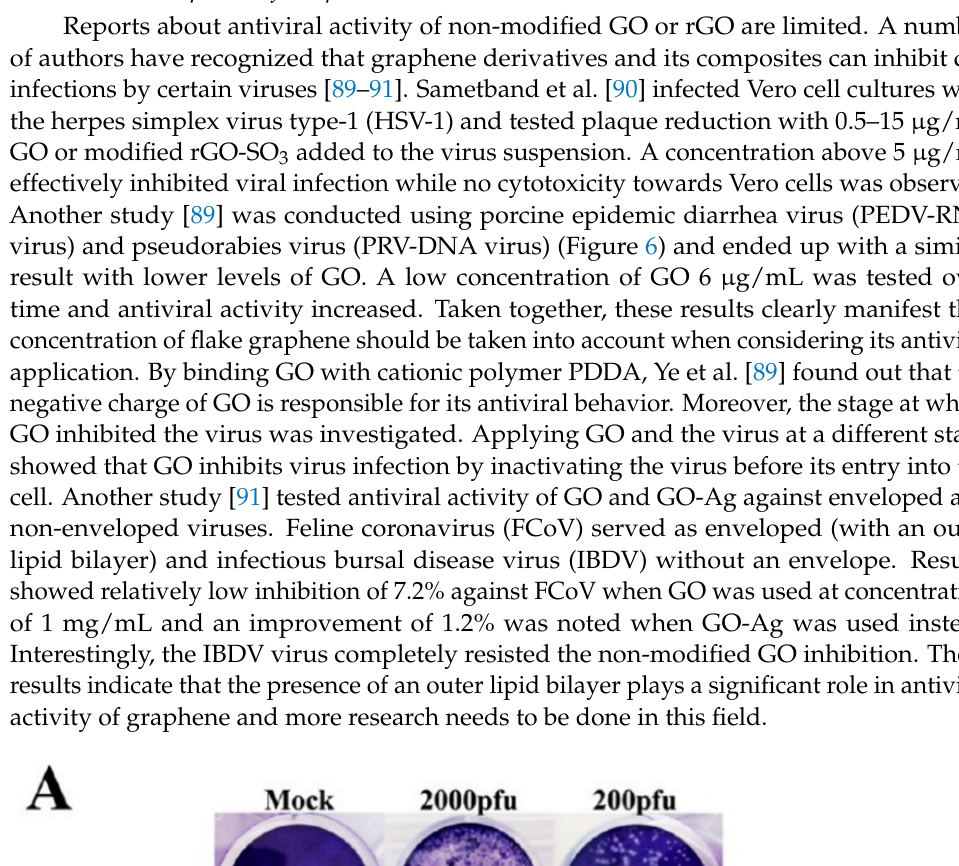
Figure 6. Antiviral activity of GO (6 µg/mL) on PK - 15 cells ( A ) and Vero cells ( B ). ( A ) Cells infected with PRV of 200 or 2000 pfu. ( B ) Cells infected with PEDV of 200 or 2000 pfu. Clear spots represent the amount of virus. Mock - infected cells serve as a control. Reprinted with permission from [89] . Copyright 2015 American Chemical Society. 5. Effects of Modifications by Graphene Derivatives 5.1. Efect of Modifications by GO/rGO on the Cellular Response of Mammalian Cells Azizi et al . [9] emphasized that three -dimensional tissue scaffolds are able to support the function of myocardium exposed to damage, which has great potential in tissue engi- neering when trying to regenerate this organ. The researchers emphasize d that a meticu- lously designed and modified architecture makes it possible to provide protection to heart muscle cells while promoting repair of damaged tissues. The specially desi gned and man- ufactured structure is implanted at the site of the myocardial infarction, so it mechanically supports the muscle, reducing the load on the heart wall, which improves myocardial performance [92]. Myocardial regeneration and improvement in myoca rdial performance depends largely on the properties of the scaffold, which stimulates the growth and differ- entiation of stem cells into myocardial cells [93]. Azizi and colleagues created polyure- thane scaffolds by the electrospinning method with structural and mechanical properties of myocardium, subjected them to some modifications, and studied the cellular response of stem cells differentiating into myocardial cells [9]. Four types of materials were pro- posed for analysis, including two modified by the addition of reduced graphene oxide (rGO) nanoparticles: polyurethane fibrous nanomaterials with directed fibers and ran- domly distributed fibers, and polyurethane fibrous nanomaterials containing reduced graphene oxide (rGO) nanoparticles , with directed fibers and randomly distributed fibers. The researchers observed that the scaffolds modified by the addition of rGO exhibited a slightly reduced average fiber diameter, presumably due to different viscosity of the com- posite solution in comparison to the pristine polymeric solution. The addition of rGO also increased the Young ’ s modulus (in the wet state to 168.3 kPa) and strength of the materi- als. It was observed that fibrous materials with directed fibers had higher elasticity than fibrous materials with randoml y directed fibers. The researchers ’ analysis showed that the